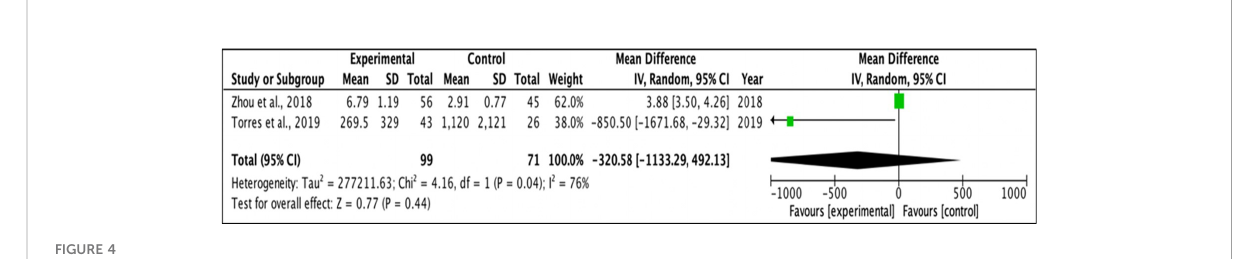
FIGURE 4 Forest plot for analysis of IL-1 b